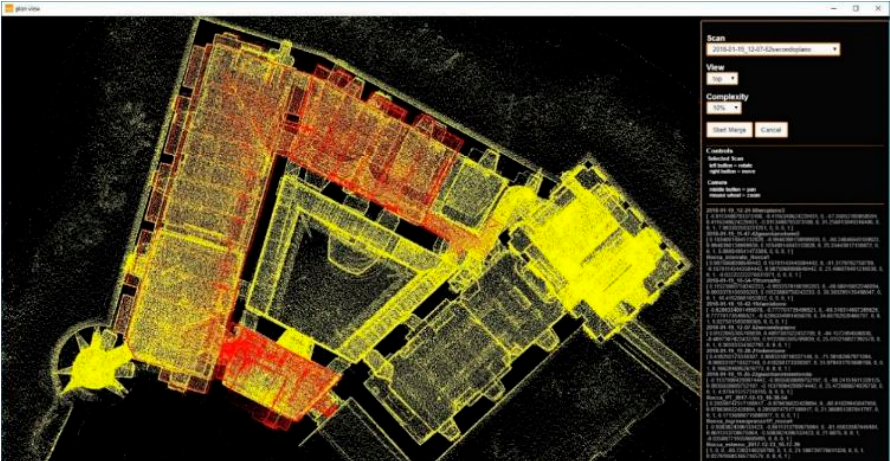
Figure 10. The desktop interface of the merge function in the GeoSLAM Hub software: in red, a single scan that is manually aligned, one at a time, to others, yellow. In the black box bottom right, the roto-translation matrix of each merged scan.